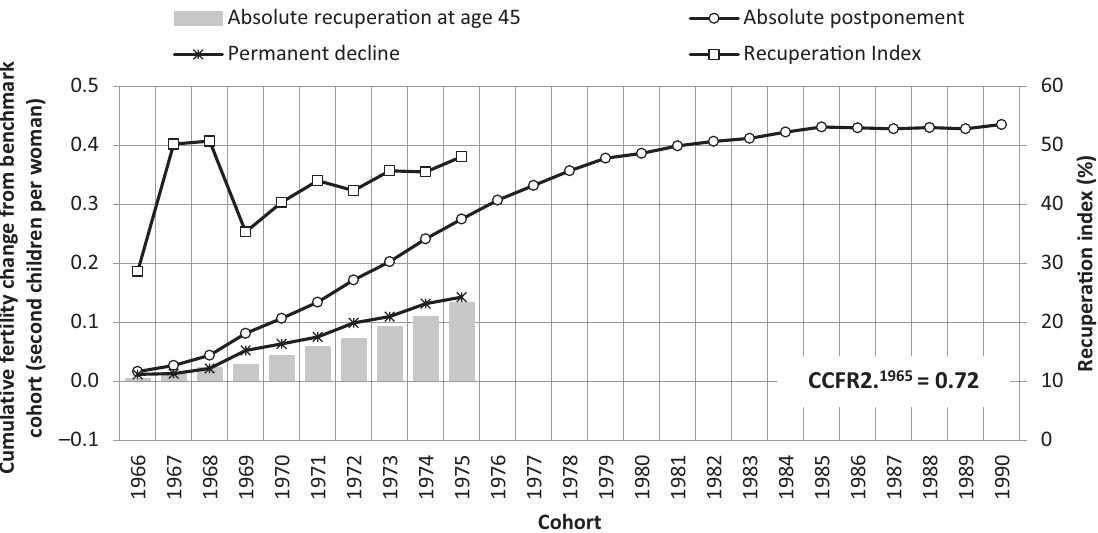
Figure 3. The postponement and recuperation of second births in Slovakia: 1966–1990 cohorts. Source: Author’s